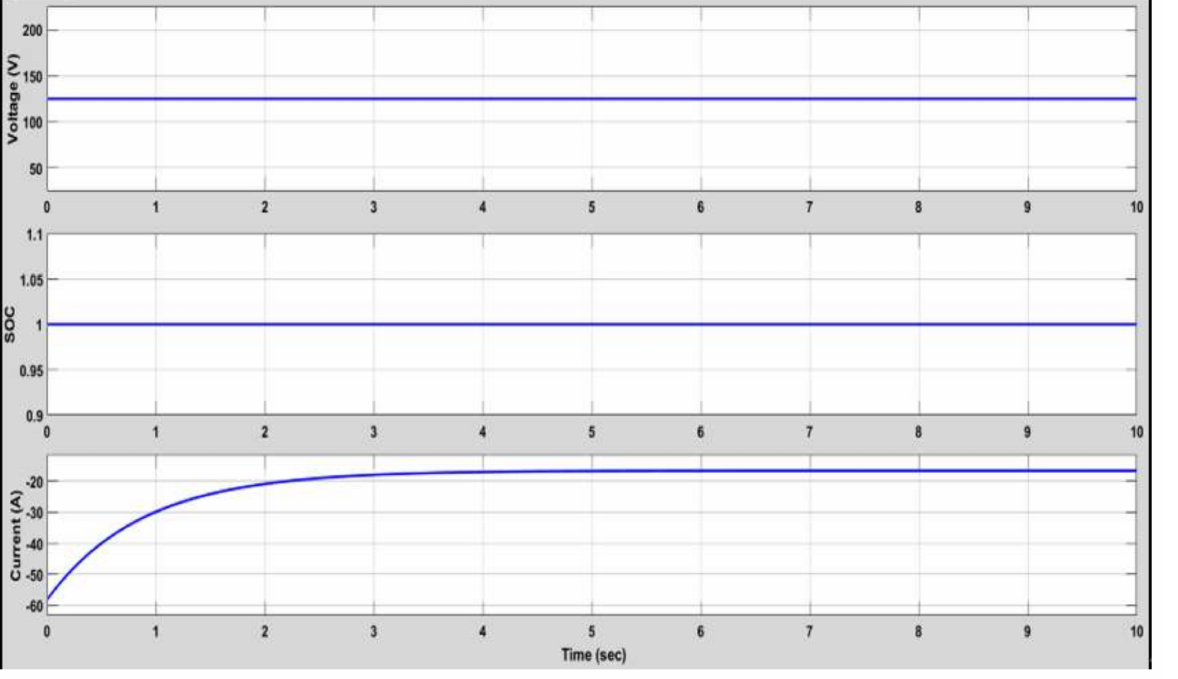
Figure 9. Performance measures of the EV while